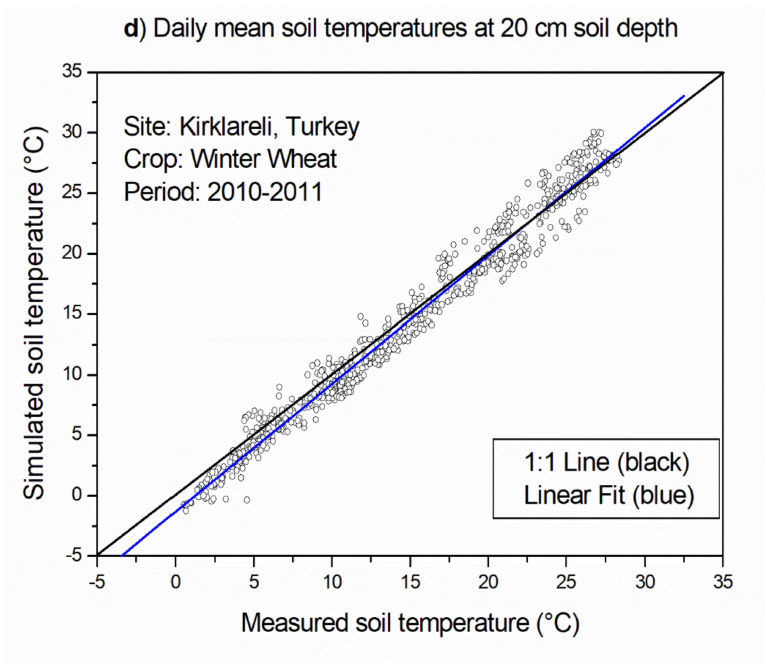
Figure 7. ( a – d ). Comparison of measured and simulated daily mean soil temperatures at three climatologically different sites in Belgium, the Czech Republic, and Turkey over the full measured temperature ranges (statistics shown in Table